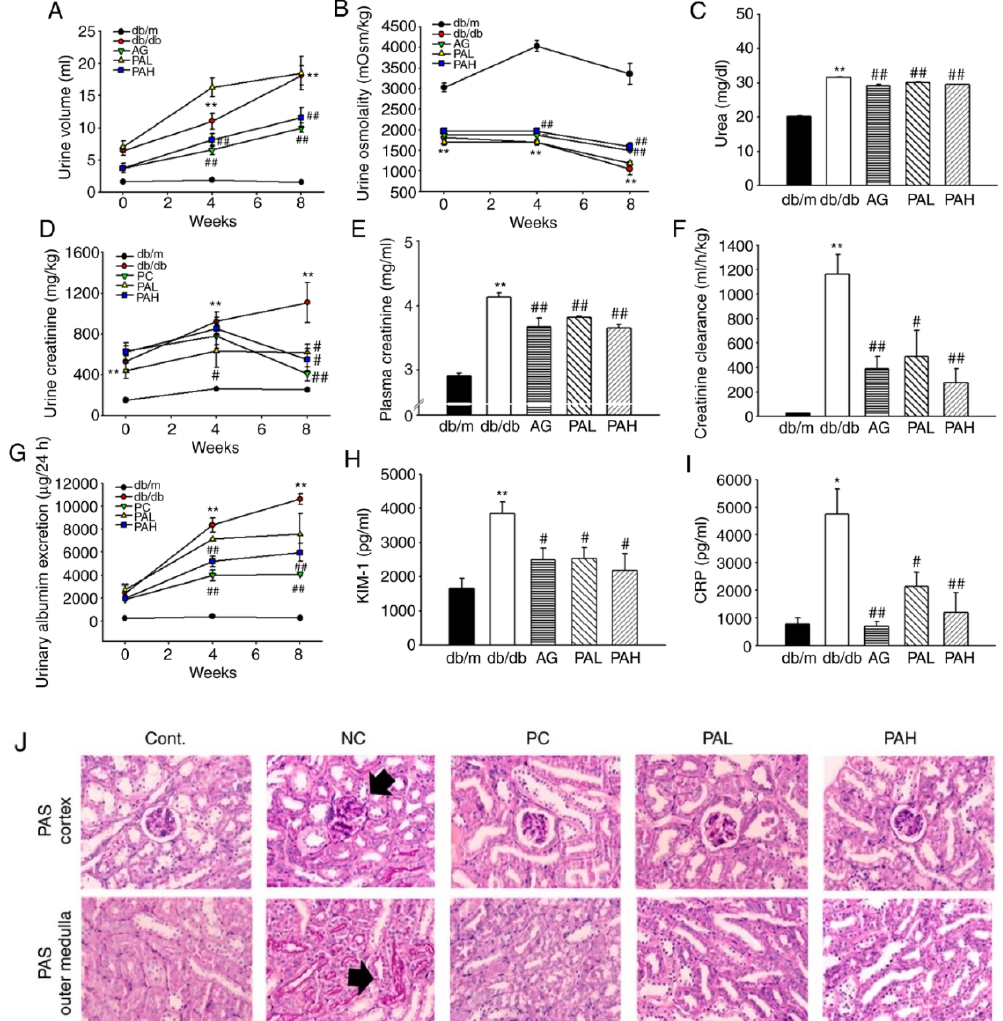
Figure 4. Effects of ER-PA on renal function and glomerular morphological changes. Effect of ER-PA on urine volume ( A ); urine osmolality ( B ); Urea ( C ); urine creatinine ( D ); plasma creatinine ( E ); creatinine clearance ( F ); urinary albumin excretion ( G ); KIM-1 ( H ) and CRP ( I ). Values are expressed as mean ± standard error of the mean ( n = 8). * p < 0.05, ** p < 0.01 vs. db/m; # p < 0.05, ## p < 0.01 vs. db/db. ( J ) Representative microscopic photographs of a kidney stained with PAS. Kidney sections in cortex (glomerulus) and outer medulla obtained from the db/m group, db/db group, AG group, PAL group and PAH group ( n ≥ 3; magnification, × 200). PA, Polygoni avicularis ; AG, db/db mice daily treated with 20 mg/kg aminoguanidine; PAL, db/db mice daily treated with a low concentration (10 mg/kg) of ER-PA; PAH, db/db mice treated daily with a high concentration (50 mg/kg) of